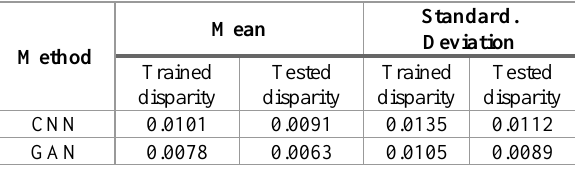
Table 3. Metrics on the disparity image during training and testing for the two models (in